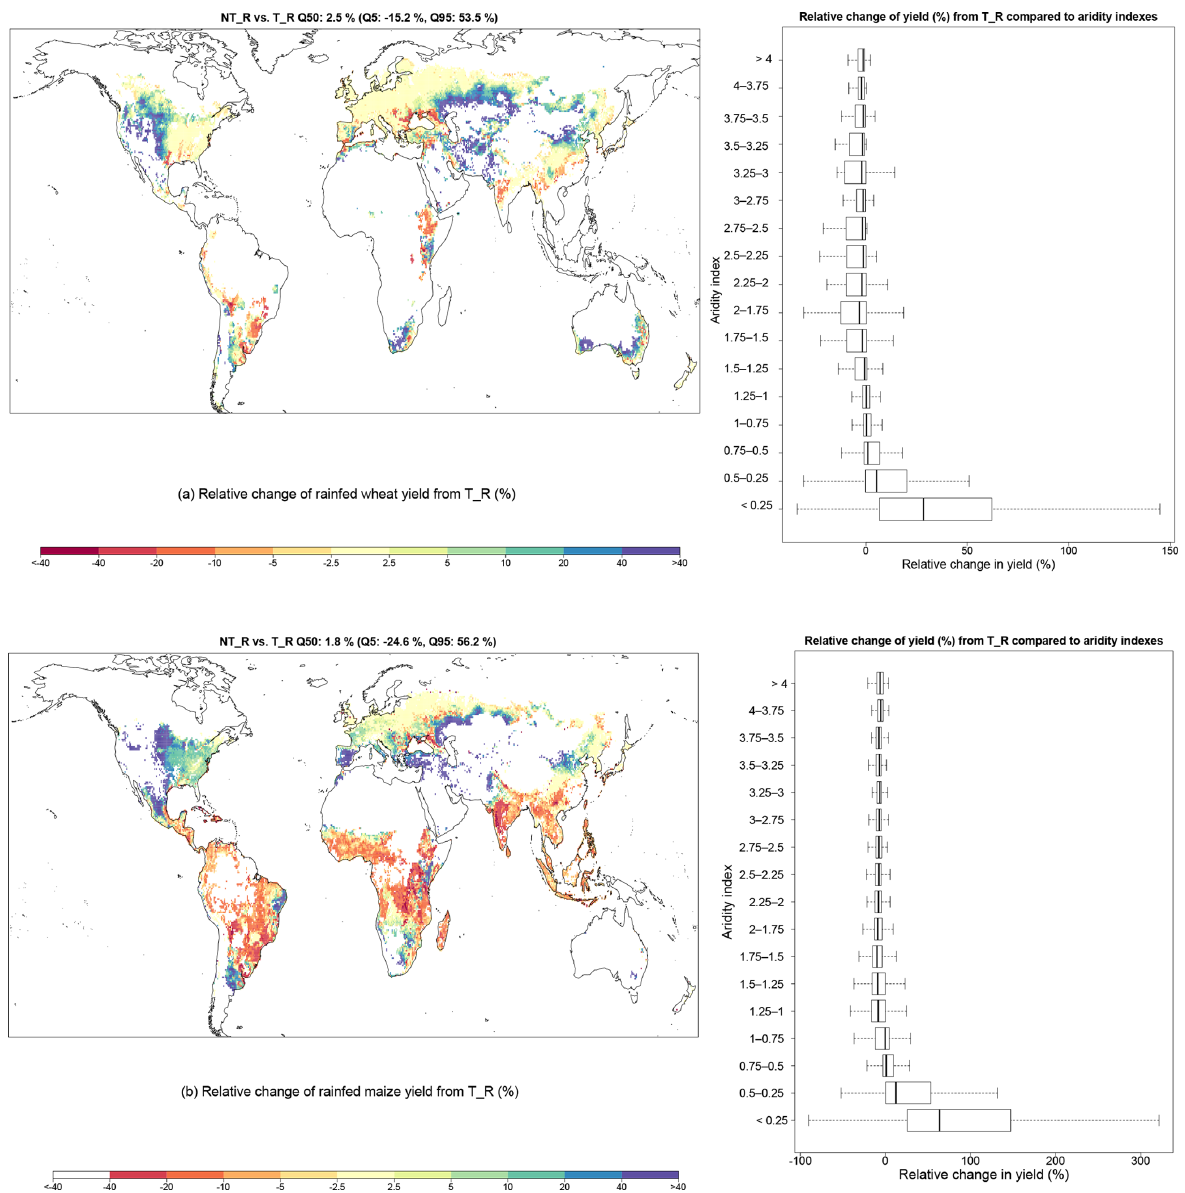
Figure 2. Relative yield changes for rain-fed wheat (a) and rain-fed maize (b) compared to aridity indexes after 10 years NT_R vs. T_R. Low aridity index values indicate arid conditions as the index is defined as mean annual precipitation divided by potential evapotranspiration, following Pittelkow et al. (2015a). Substantial increases in crop yields only occur in arid regions, with aridity indices < 0 .